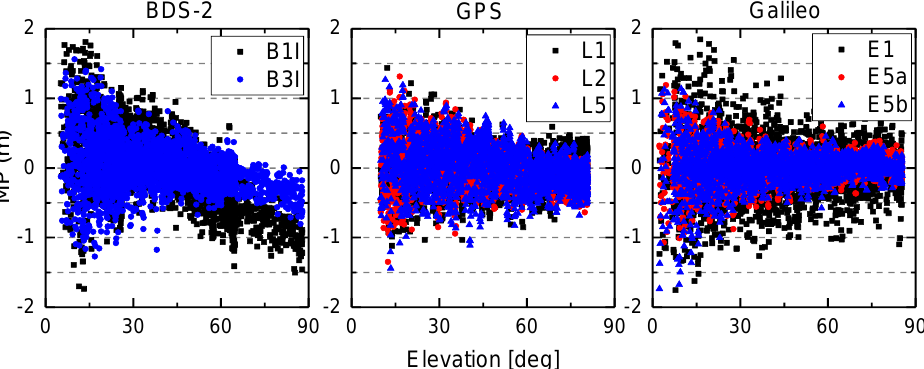
Figure 6. Multipath (MP) series of tracked signals of BDS-2 (B1I/B3I), GPS (L1/L2/L5), and Galileo (E1/E5a/E5b) satellites as a function of satellite elevation at WUH1 station.